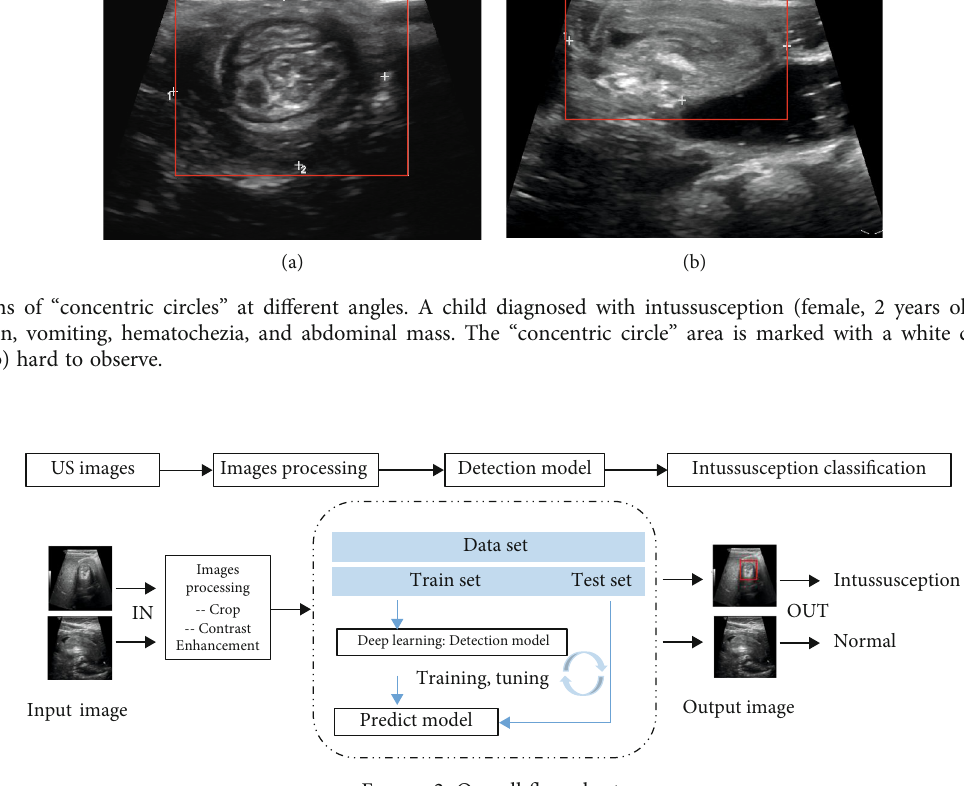
Figure 2: Overall fl ow